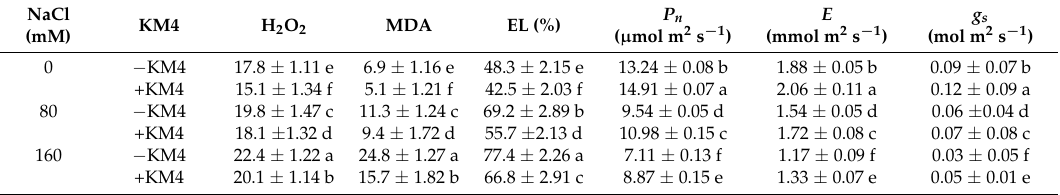
Table 5. Levels of H 2 O 2 , μ mol g − 1 FW), MDA (nmol g − 1 FW), EL (%), and gas exchange parameters in maize leaves in the presence or absence of Serratia liquefaciens KM4 under salt